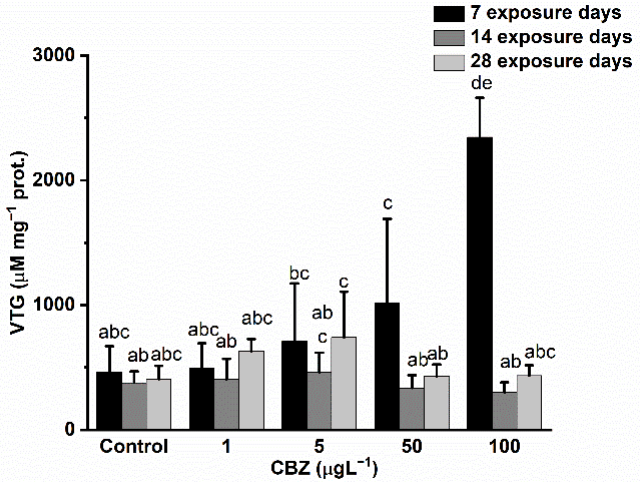
Figure 6. Changes in the VTG levels in the gonads of Cyprinus carpio exposed to CBZ for 7, 14, and 28 d. Data are expressed as mean ± standard deviation of three replicates ( n = 3). Different letters designate significant differences at p < 0.05 after a two ‐ way ANOVA followed by Tukey’s post ‐ hoc test. 3.4. Damage Markers The DNAsb measured in liver samples was slightly decreased as compared to con ‐ trols during the first two weeks of exposure to CBZ, with differences in measured levels diminishing by the fourth week of exposure. Differences (decrease) in experimental DNAsb levels compared to the control groups proved significant only with 1 μ g/L CBZ